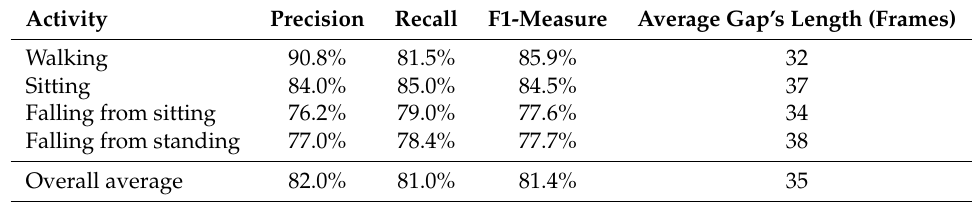
Table 4. The recognition results of the four fall-related activities from partially-observed videos when the missing subsequence of frames is at the beginning of the testing video sequences. Activity Precision Recall F1-Measure Average Gap’s Length (Frames) Walking 90.8% 81.5%